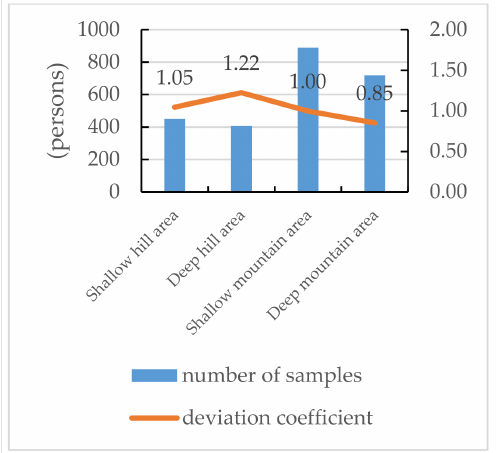
Figure 15. Deviation coefficient of agricultural machinery utilization rate grouped by terrain. .